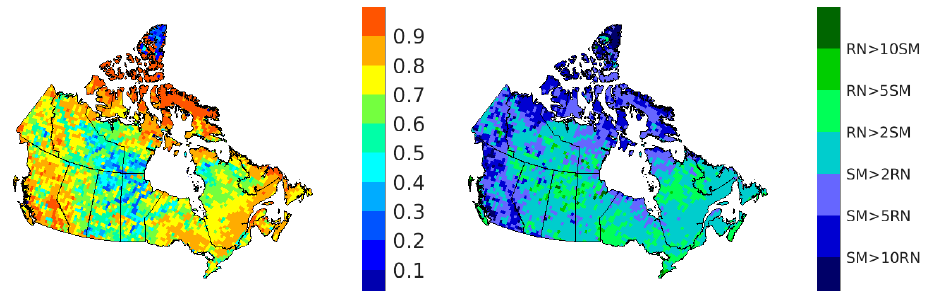
Figure 3. Correlation coefficient between streamflow and accumulated snowmelt/rainfall upstream of respective grid cell in GEM for the 150 largest streamflow events during the 1981–2010 period ( left ). Relative average snowmelt (SM) and rainfall (RN) contribution during those events ( right ).